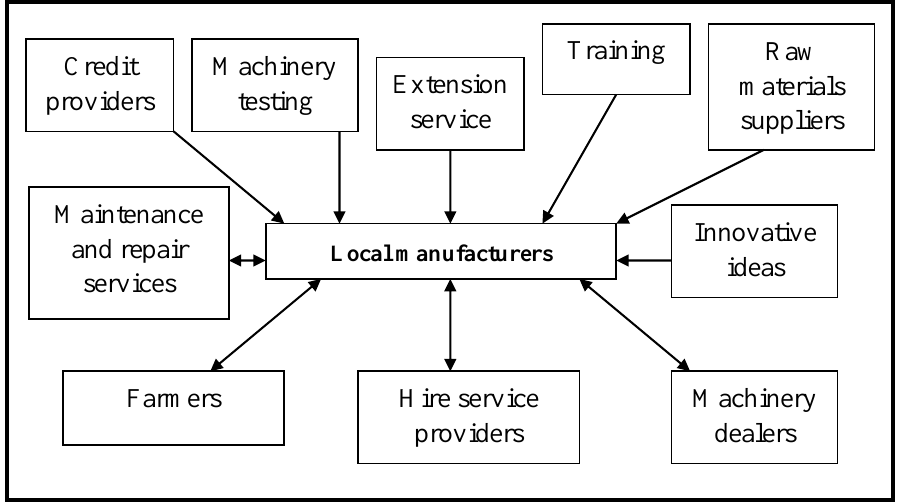
Figure 4. Mechanization supply chain stakeholder interactions from the perspective of local manufacture (source: [18]).